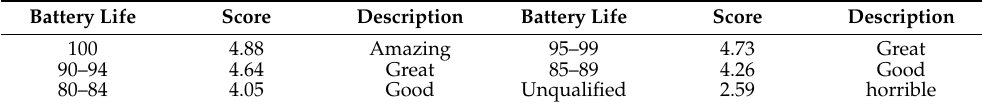
Table 11. Sentiment score of the battery